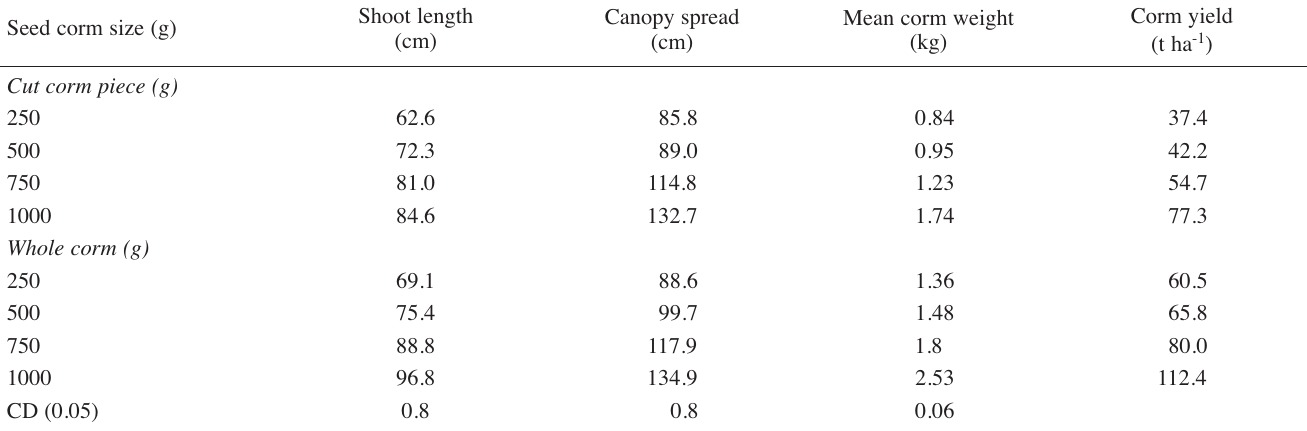
Source: Sen and Das, 1991. Table 6 - Effect of seed corm size on shoot length, canopy spread, mean corm weight and corm yield